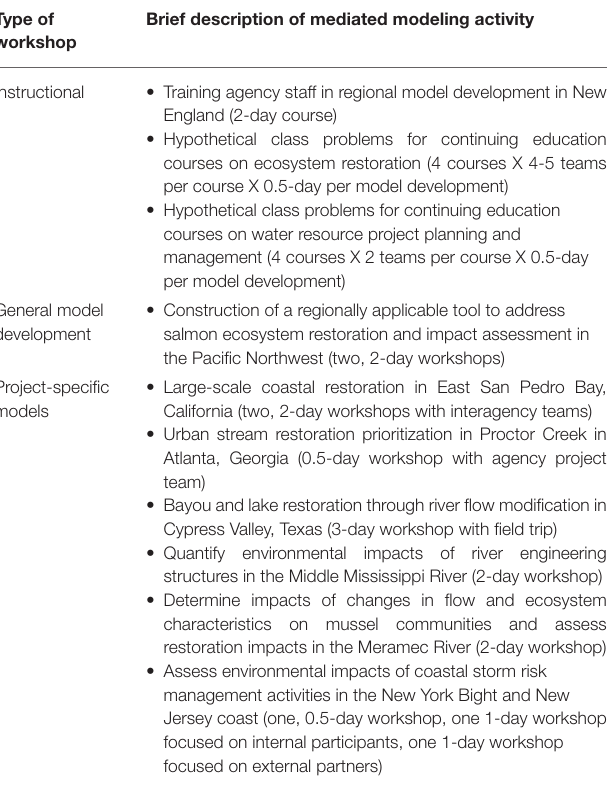
TABLE 1 | Case studies applying the overarching mediated modeling workshop approach described in this